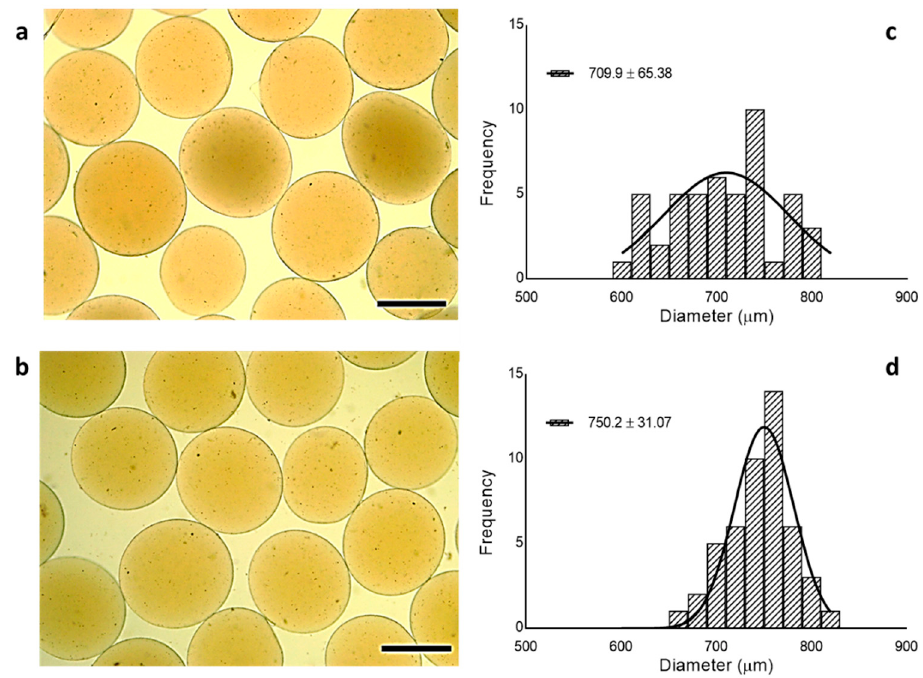
Figure 2. Optical images of ( a ) Alg and ( b ) Alg/Gel microgels (Scale bar: 500 µm) and relative diameter distribution ( c , d ).